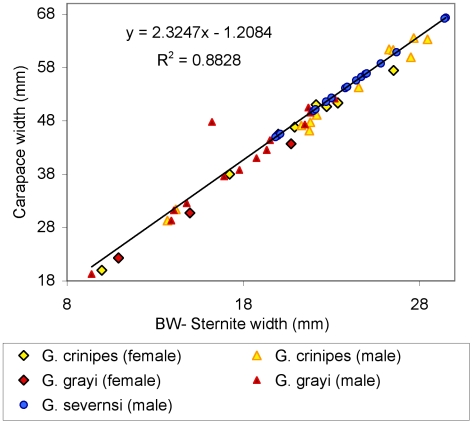
Regression between widths of carapace and posterior width of 4th sternite (BW) in Geograpsus, with estimated carapace widths of G. severnsi plotted on regression obtained from living species.